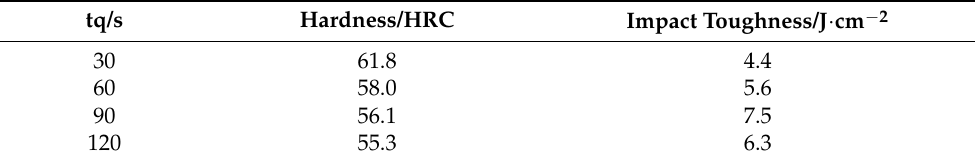
Table 2. The hardness and impact toughness of samples treated at different